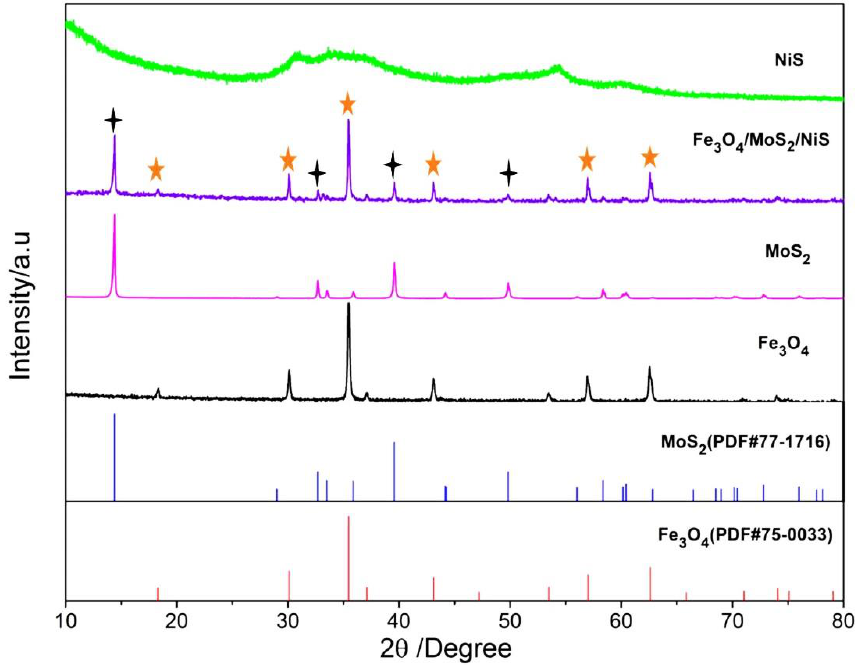
Figure 1. XRD patterns of the Fe 3 O 4 , NiS, MoS 2 and Fe 3 O 4 /MoS 2 /NiS (5%) samples. (The black as- terisk in the figure represents MoS 2 , and the orange asterisk represents Fe 3 O 4